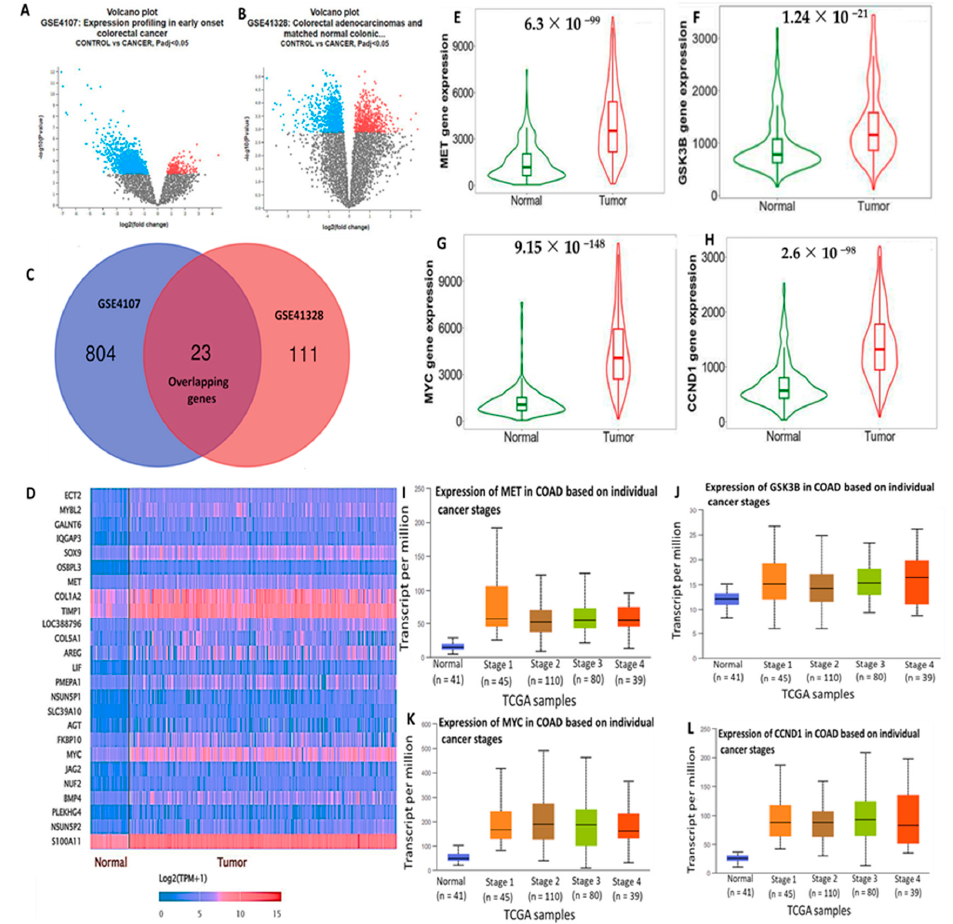
Figure 2. Overexpression of c-Met/GSK3 β /MYC/CCND1 promotes colon cancer progression. ( A , B ) Volcano plots showing top overexpressed DEGs in COAD tissues compared to normal tissues were retrieved from two NCBI GEO datasets, GSE4107 and GSE41328. ( C ) Venn diagram showing the overlapping upregulated genes from the two datasets. ( D ) Heatmaps showing the top differentially expressed genes in colon adenocarcinoma (COAD). ( E – H ) c-Met, GSK3 β , MYC, and CCND1 were highly expressed in colon cancer tissues compared to adjacent normal tissues. ( I – L ) c- Met/GSK3 β /MYC/CCND1 were overexpressed in colon cancer from stages 1~4 compared to normal tissues, with p < 0.05. considered statistically significant.